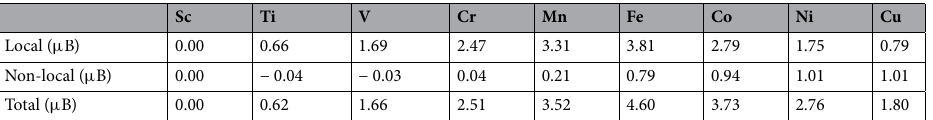
Table 3. The spacial distribution of the magnetic moment, in µ B , in the slab for each dopant species when doped into the surface (position 1 in Fig. 1). The portion of the magnetic moment attributed to the dopant atom is listed under Local, the sum of the magnetic moments on all atoms except the dopant is listed under Non-local, and the total magnetic moment induced in the slab (sum over all atoms) is listed under Total.